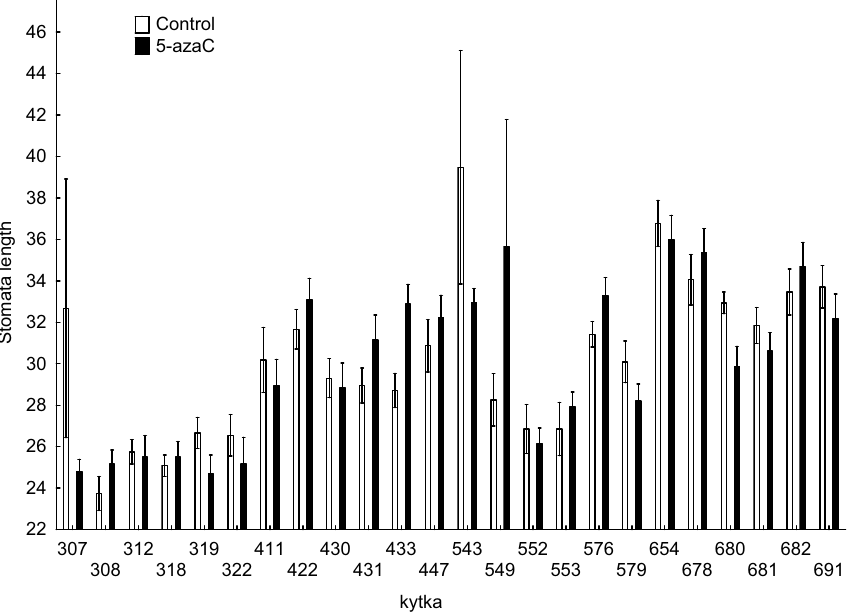
Figure 3. Differences in response to 5-azaC application among different genotypes. Each pair of bars represents one genotype. The genotypes are grouped by their environment of origin. Pairs of columns marked with * are significantly (p < 0.05) different from each other. The data were measured at the end of the experiment using 6 replicates of each of 6 genotypes from each of 4 populations of origin grown in 2 growth chambers, all subjected to control and 5-azaC treatments, resulting in 576 experimental plants. The overall test is reported in Table 1.